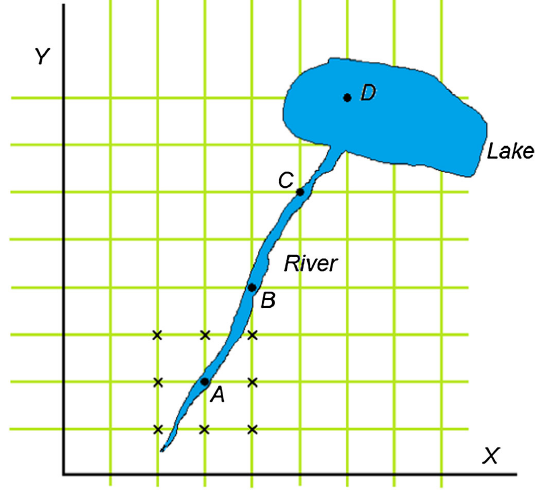
FIG. 6. Brute force optimization does not lead to the